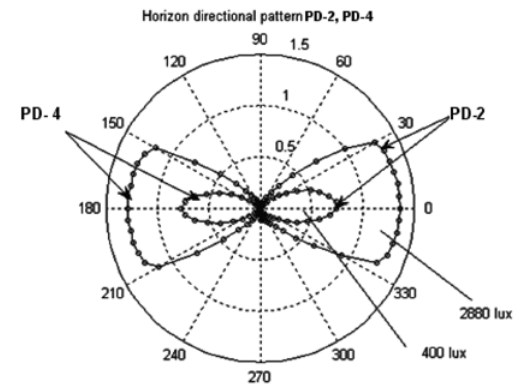
Fig. 11. Output characteristics of sensor unit (bank)